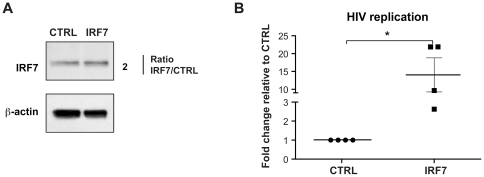
IRF7 overexpression increases HIV-1 replication in primary macrophages.A) Western blot for IRF7 protein, 24 hours post-transfection of macrophages overexpressing IRF7 showed a 2 fold increase compared to empty vector control. The densitometry of the bands was normalized to that of β-actin. The ratio is shown next to the respective panels. Results shown are representative of 2 independent experiments. B) TAT spliced expression was augmented 14 fold in primary human macrophages overexpressing IRF7 compared to empty vector control. The qRT-PCR results were normalized to the level of 18 S. An * denotes a significant difference (P<0.05, one sample t-test) compared to the empty vector control. Each symbol in a group represents one independent donor.